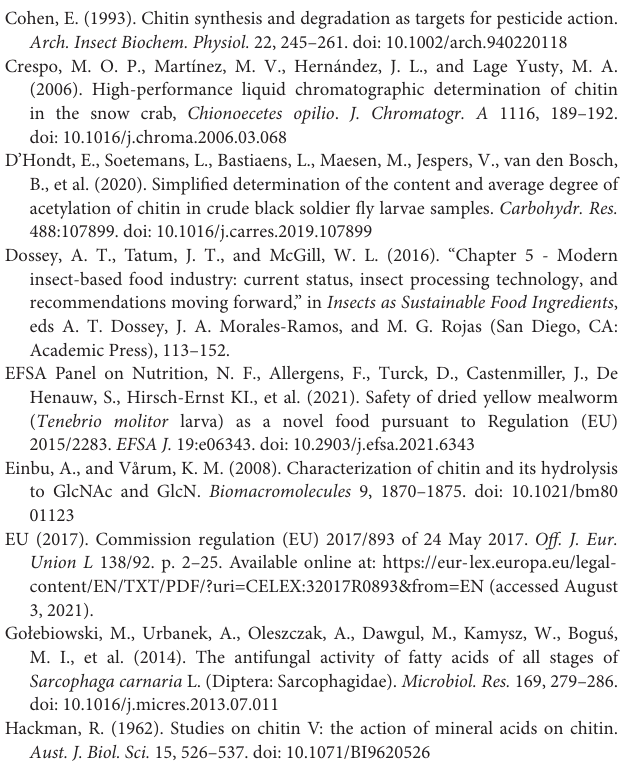
Supplementary Figure 3 | LC-ECD chromatogram of glucosamine and N -acetylglucosamine